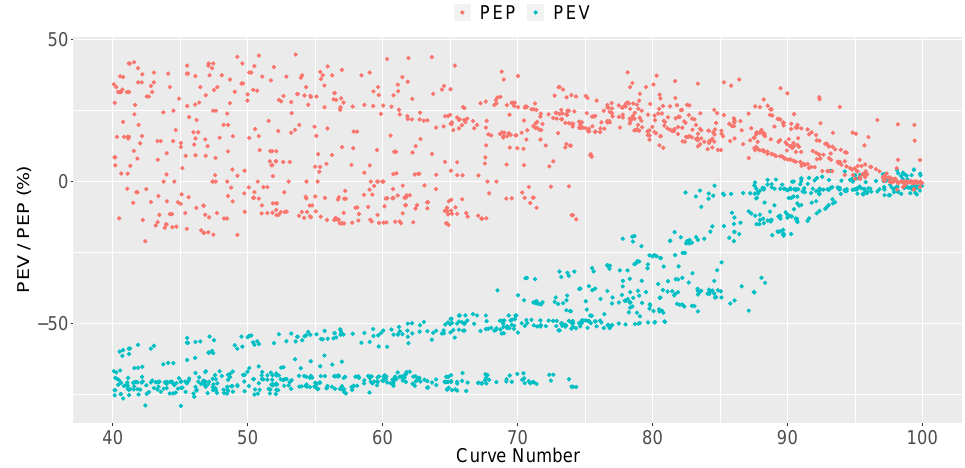
Figure 8. Computed PEV and PEP values for fitted hydrographs for each selected